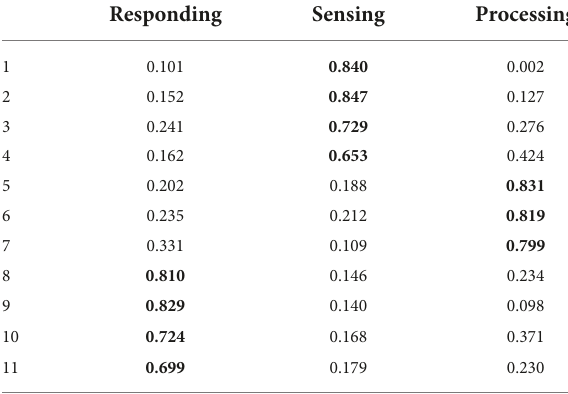
TABLE 3 Factor loadings of exploratory factor analysis for the Chinese version of the active-empathic listening scale (AELS). Responding Sensing Processing